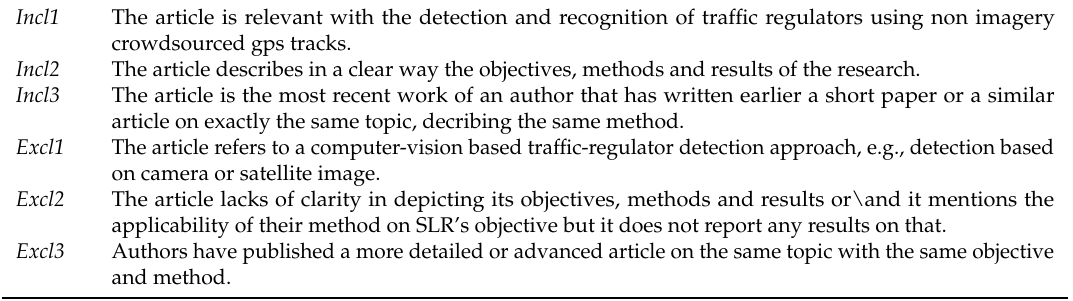
Table 5. The defined inclusion and exclusion criteria that were applied during the Screening and Eligibility steps of the